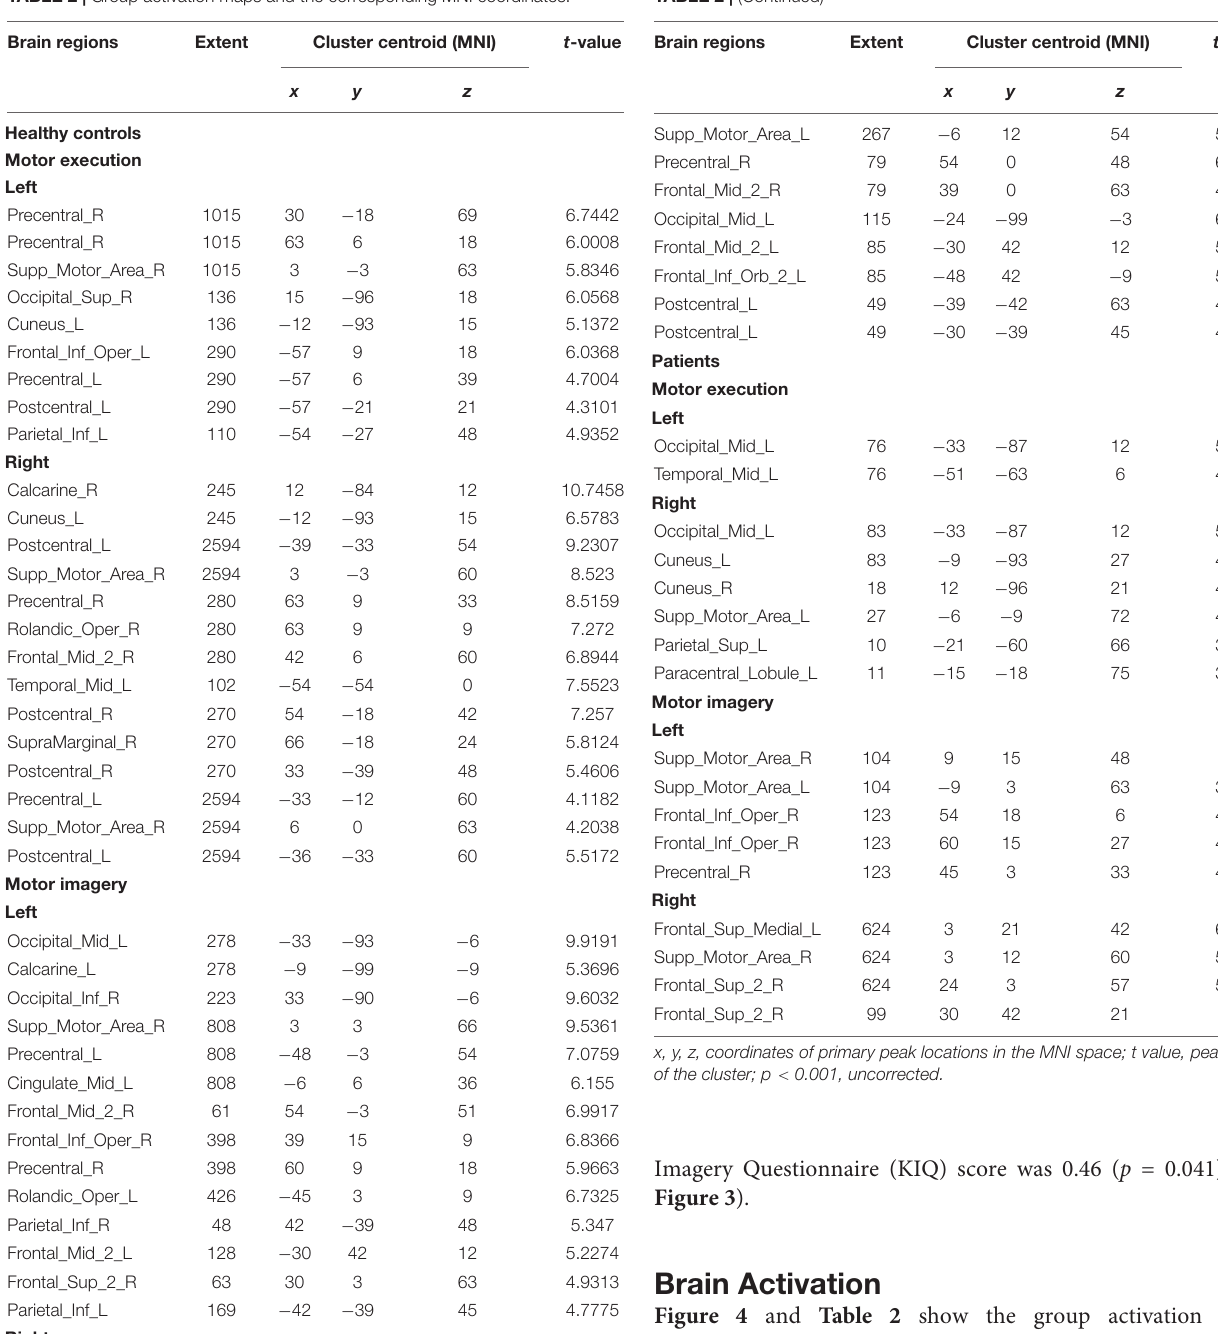
Figure 4 and Table 2 show the group activation maps and corresponding Montreal Neurological Institute (MNI) coordinates of the activated brain regions during the conditions in the different tasks performed with the affected hand (AH) and unaffected hand (UH). It is worth noting that during the motor execution task of the AH, the supplementary motor area (SMA) and paracentral lobule, superior parietal gyrus (SPG), and occipital gyrus ipsilateral to the lesion were activated. During motor imagery of the AH, activity was seen in the SMA and SPG in contralateral to the lesion, and medial SPG in the ipsilateral